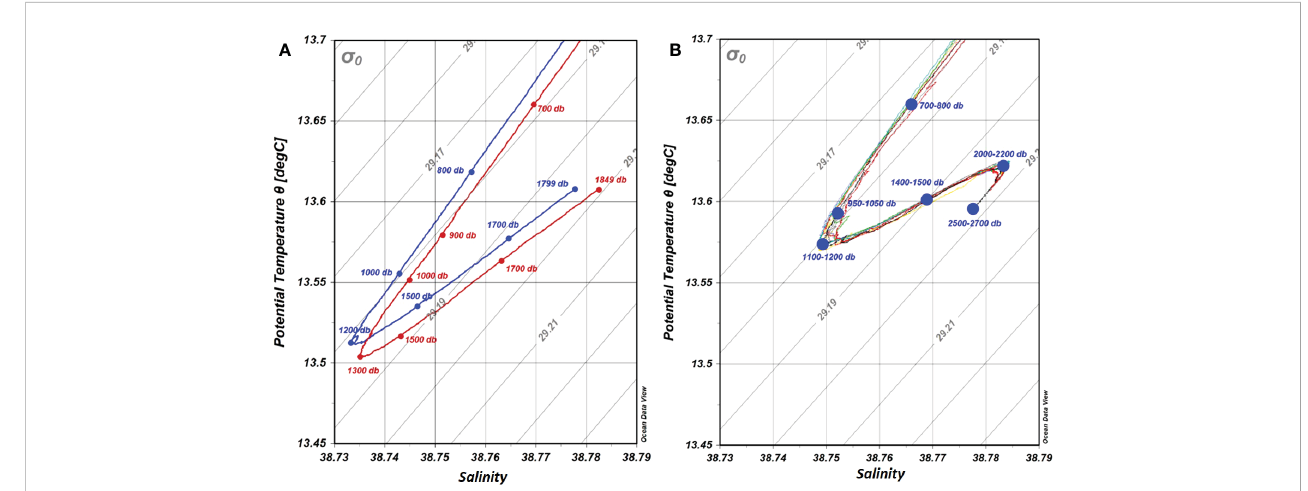
FIGURE 4 T/S diagrams of the EMTW in the SE Levantine: a) from a deep station south of Cyprus for CYBO 12 (Aug 2001) in blue and for CYBO 14 (Aug 2002) in red and b) from all deep stations (below 2000 dbar) for CYBO-HaiSec 25 (Dec